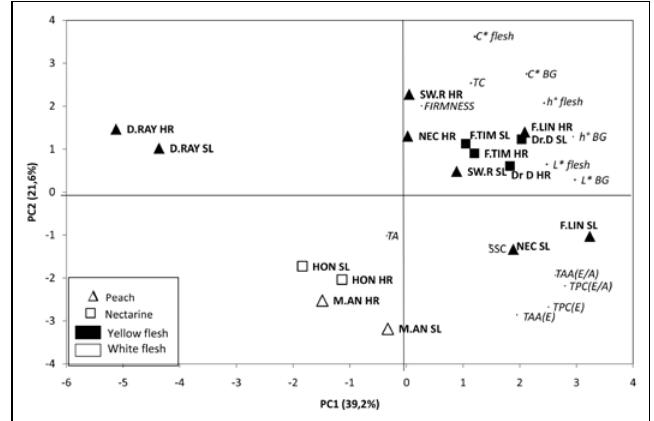
Fig. 4 - Principal component analysis of quality characteristics and bioactive compounds of eight peach and nectarine cultivars at harvest (HR) and after shelf-life (SL). Cultivars: HON= Hon- ora; Dr.D= Dr. Davis; F.TIM=Fairtime; M.AN= Maria Anna; D.RAY= Diamond Ray; F.LIN=Fairline; NEC=Nectaross; SW.R=Sweet Red. Factors: SSC= soluble solids content; h °, C*, L*= color parameters; BG= peel background; TC= total carotenoids content; TA= titratable acidity; TAA= total anti- oxidant activity; TPC= Total phenol content; (E) ethanol/HCl extract; (E/A)=Ethanol/acetone